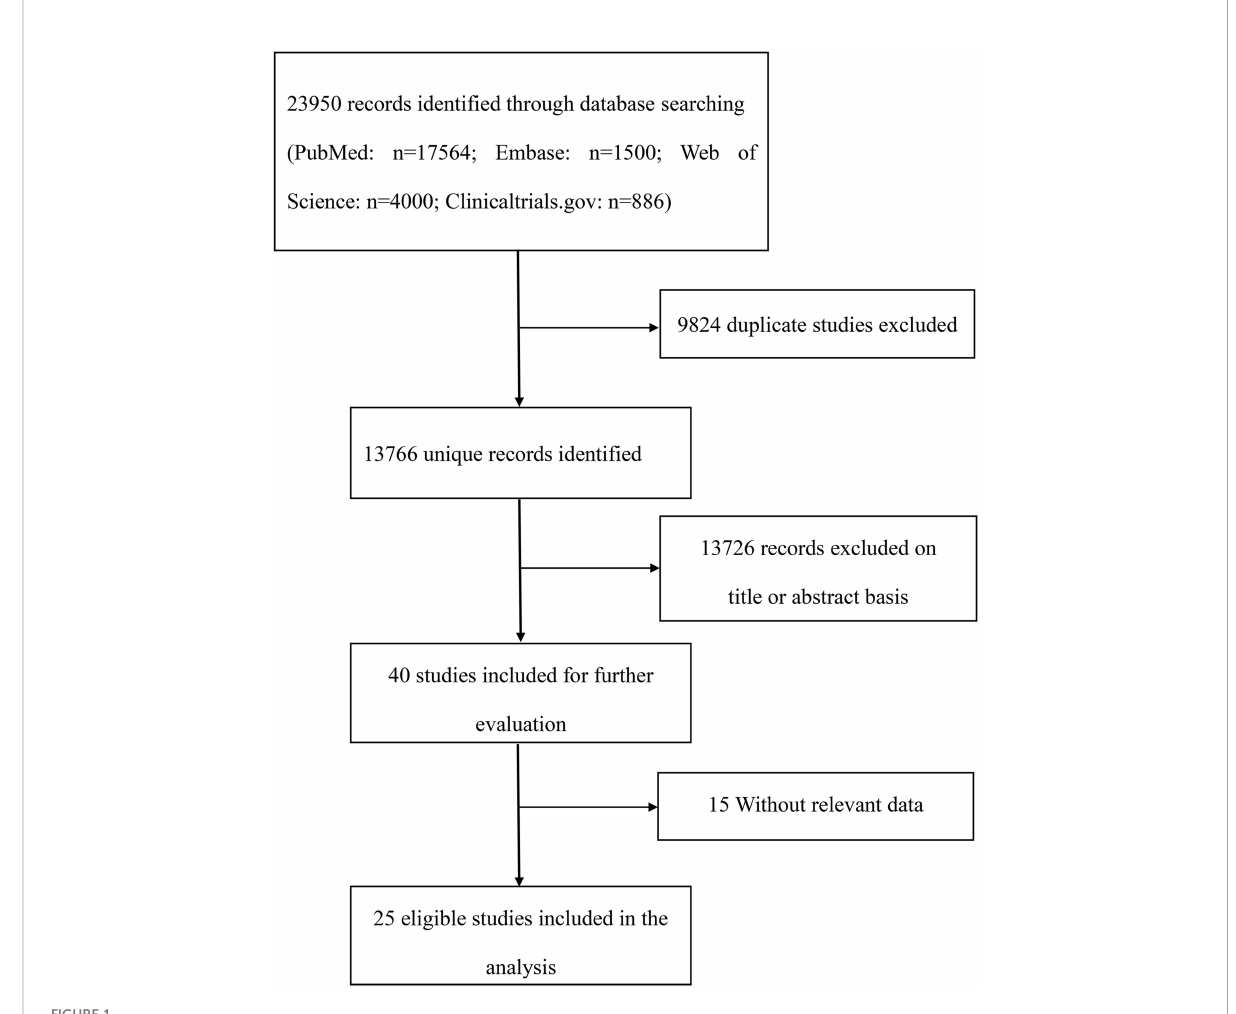
FIGURE 1 Flow diagram of the study selection